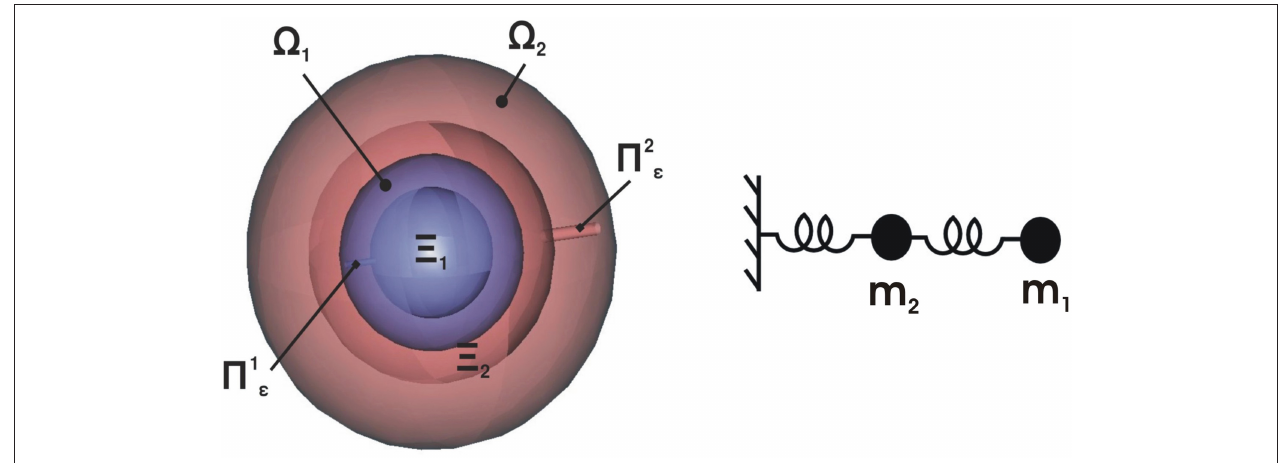
FIGURE 10 | Geometry of the inclusions and the Helmholtz oscillator consisting of two masses connected by a spring, with one of them connected to a fixed domain.